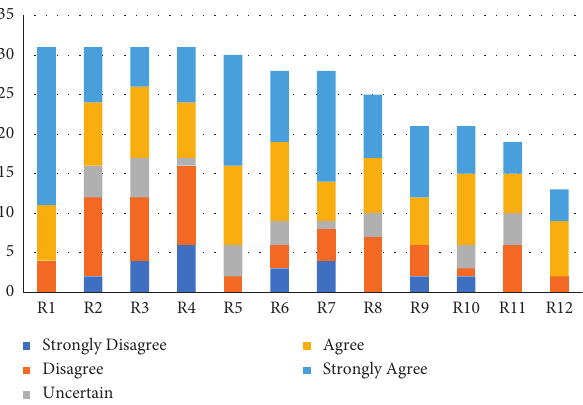
Figure 5: Autodelete data algorithm evaluation chart. Table 3: Identification of client security techniques.